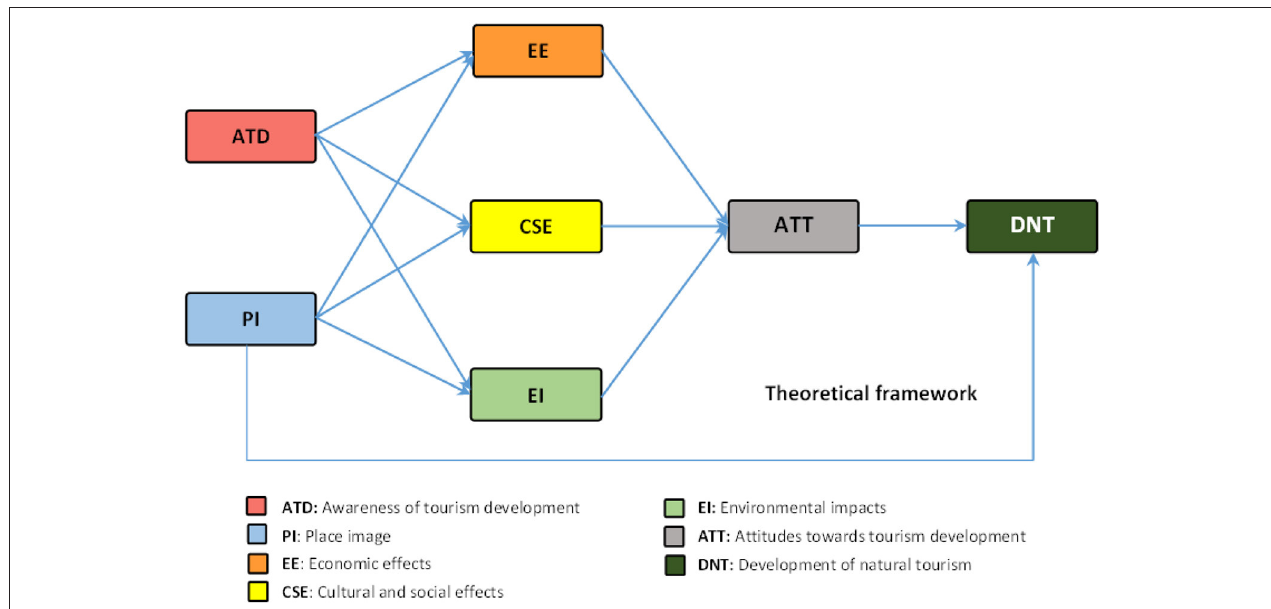
FIGURE 1 | Theoretical framework of the study based on SET in the analysis of tourism development in the pandemic of COVID-19